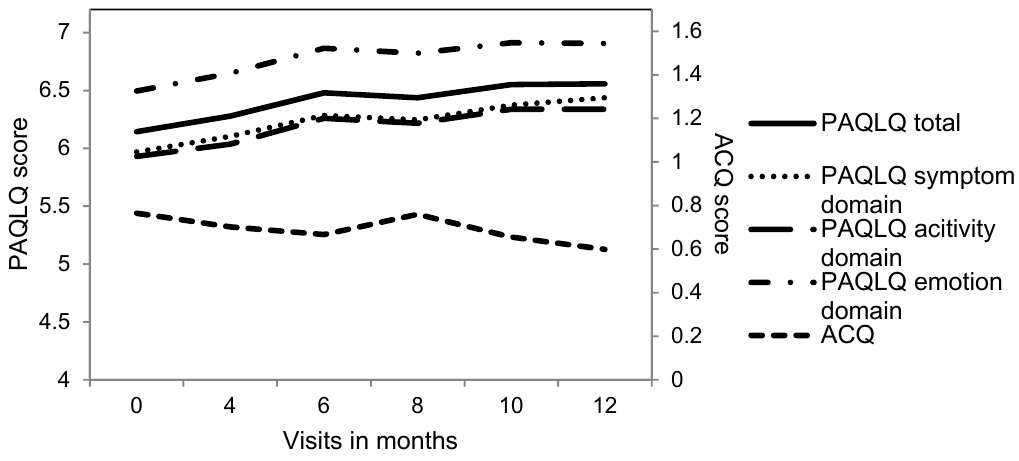
Figure 1. Overview of the course of the PAQLQ and ACQ scores during 12 months. On the right-hand side, the scale and numbers of the ACQ score are given, on the left-hand side, the scale and numbers of the PAQLQ score.